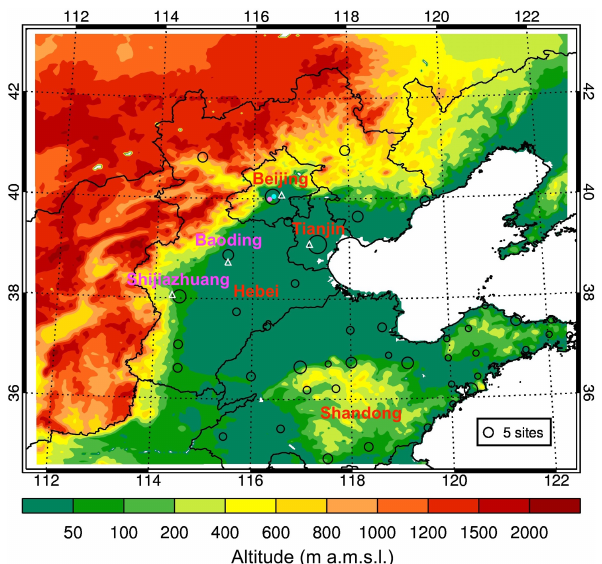
Figure 1. Model domain with the topography. The black circles de- note the locations of the cities with ambient air quality monitoring sites, and the size of the circles represents the number of sites in each city. The white triangles show the location of the meteoro- logical stations in Beijing, Tianjin, Shijiazhuang, and Baoding. The light blue and pink dots in Beijing show the observation sites with the POA / SOA (NCNT) and OC / EC (CRAES) measurements, re- spectively.